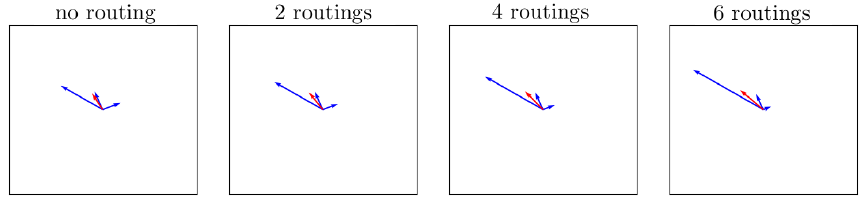
Figure 2: Effects of the routing / squashing combination. In blue we show the inter- mediate vectors, in red we show the output vector after